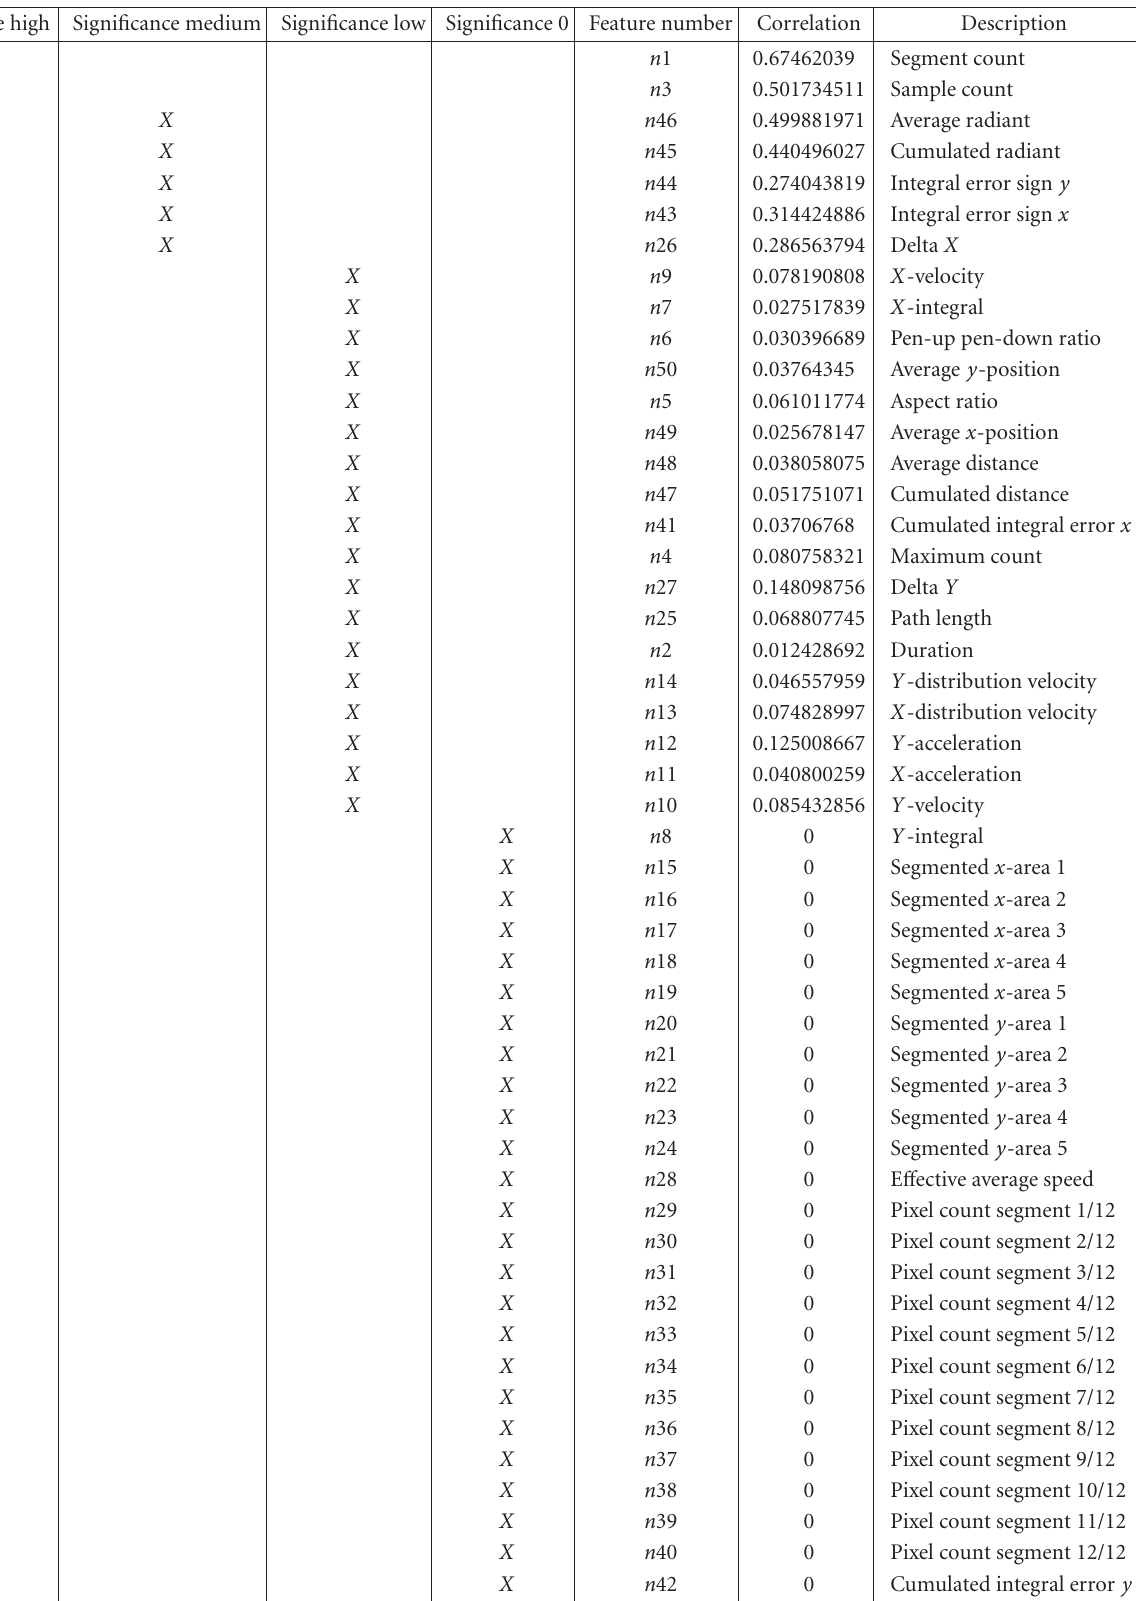
Table 5: Feature significance